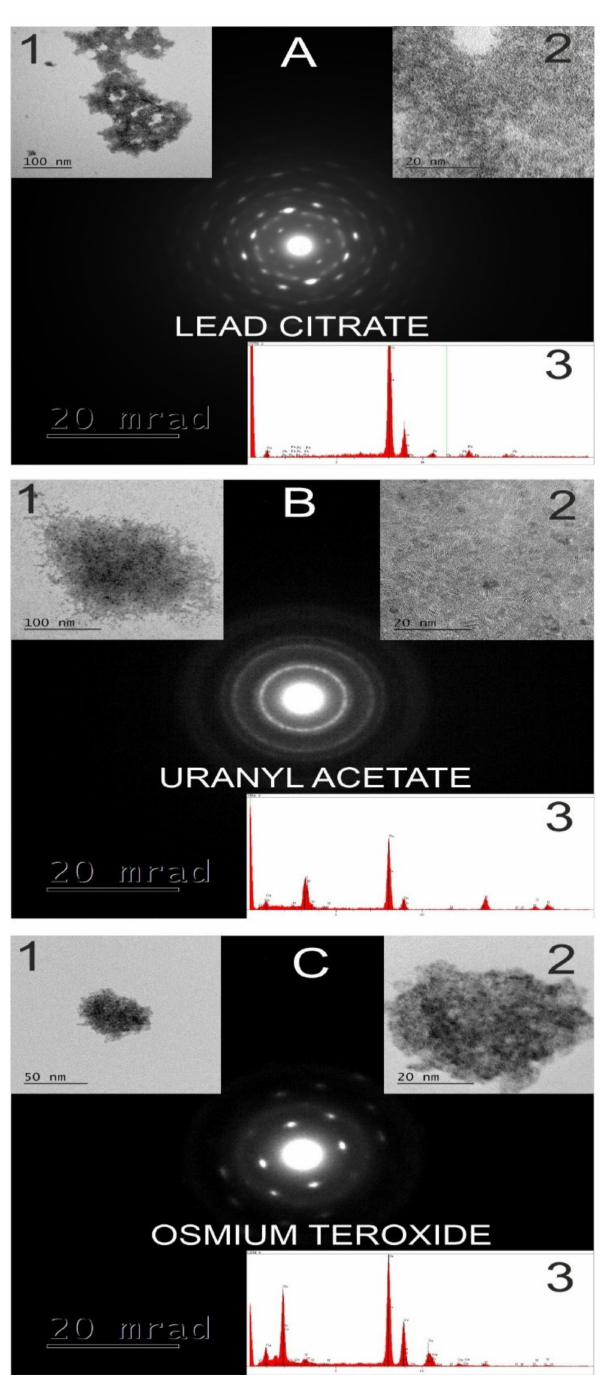
Figure 2. HRTEM of the electron-dense particles detected during the procedure for sample prepa- ration for electron dense electron microscopy analysis. ( A ) Diffraction pattern of the lead citrate spots; inset 1—spots visible under a lower magnification, inset 2—under a higher magnification and inset 3 EDS-TEM analysis of the analyzed spots. ( B ) Diffraction pattern of uranyl acetate spots; inset 1—spots visible under a lower magnification, inset 2—under a higher magnification with clearly visible “fingerprints” of the uranyl acetate and inset 3—EDS-TEM analysis of the analyzed spots. ( C ) Diffraction pattern of the osmium tetroxide spots; inset 1—spots visible under a lower magnification, inset 2—under a higher magnification with clearly visible “fingerprints” of the osmium tetroxide and inset 3—EDS-TEM analysis of the analyzed